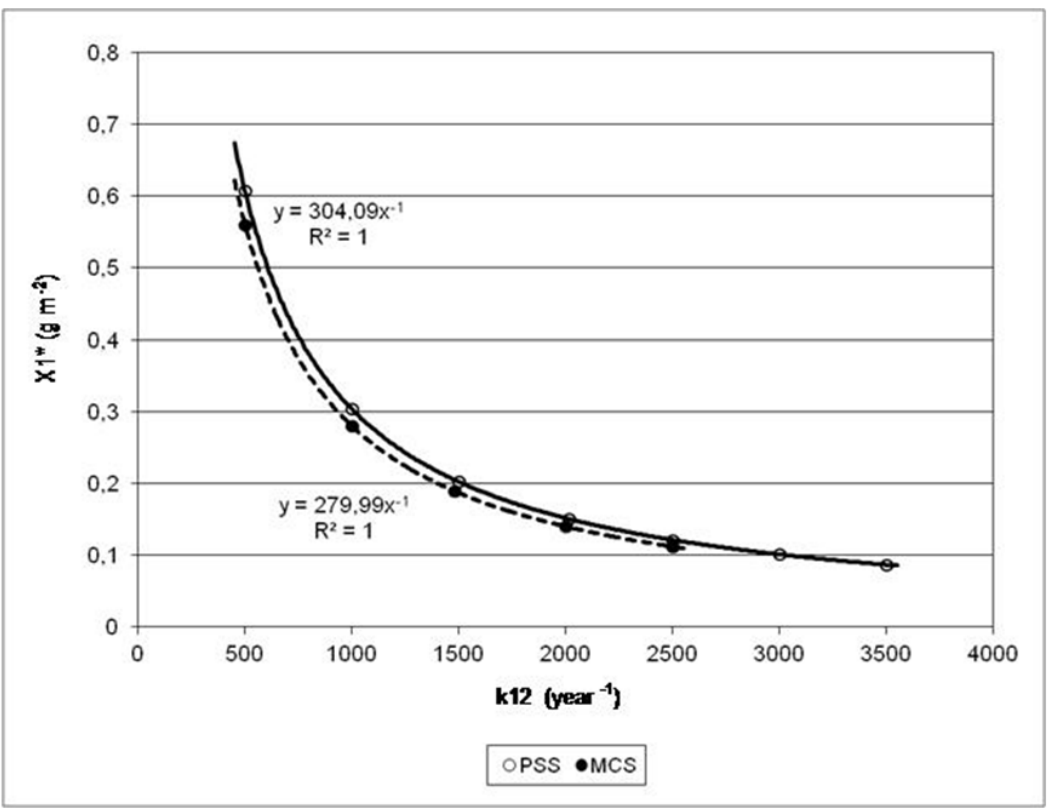
Figure 5. The dependence of X 1 air on input parameter k 12. Most sensitive to variation of constant values k